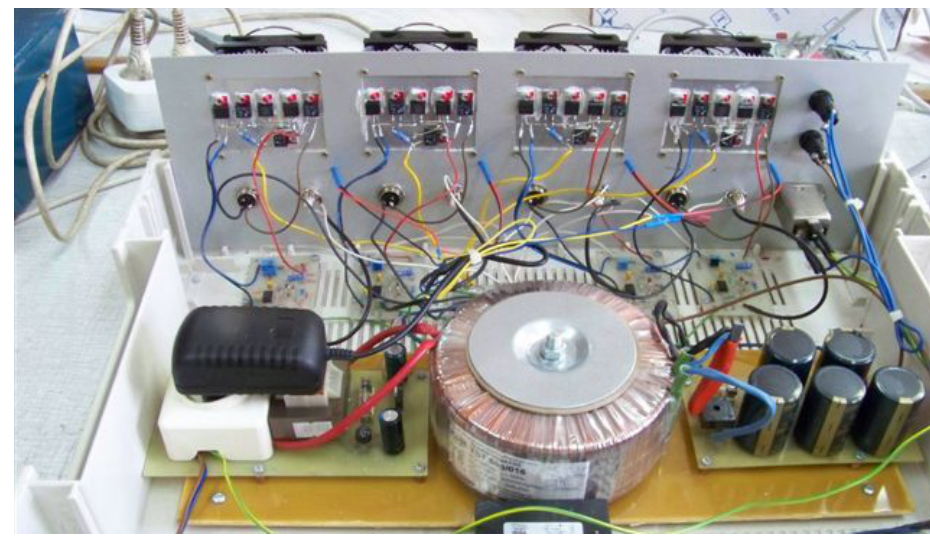
Figure 3. Internal view of the 4-channel